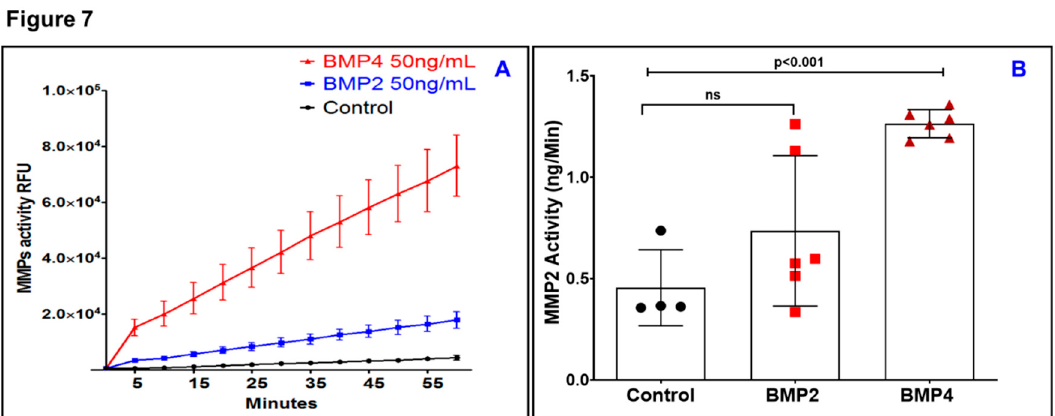
Figure 7. Sensolyte assay for kinetic analysis of matrix metalloproteinase (MMP) activity after BMP2- or BMP4-treatment. ( A ) A remarkable increase (~6 fold) in the slope of substrate cleavage by MMPs was seen against time for the BMP4-treated ARPE-19 cells in comparison with BMP2-treated ARPE-19 cells. ( B ) MMP2 activity was significantly ( P < 0.001) increased after exposure to BMP4 but not BMP2; Black circles: control; Red squares: BMP2; Red Triangles: BMP4. Results are presented as mean ± SD; n = 4–6 per